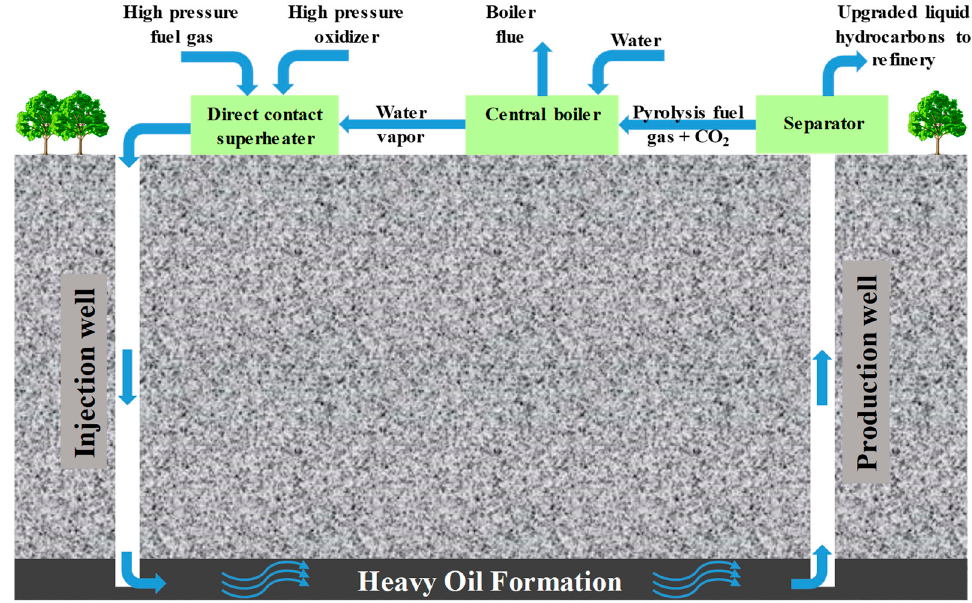
Figure 1. Simplified process diagram for EOR using superheated steam stimulation.